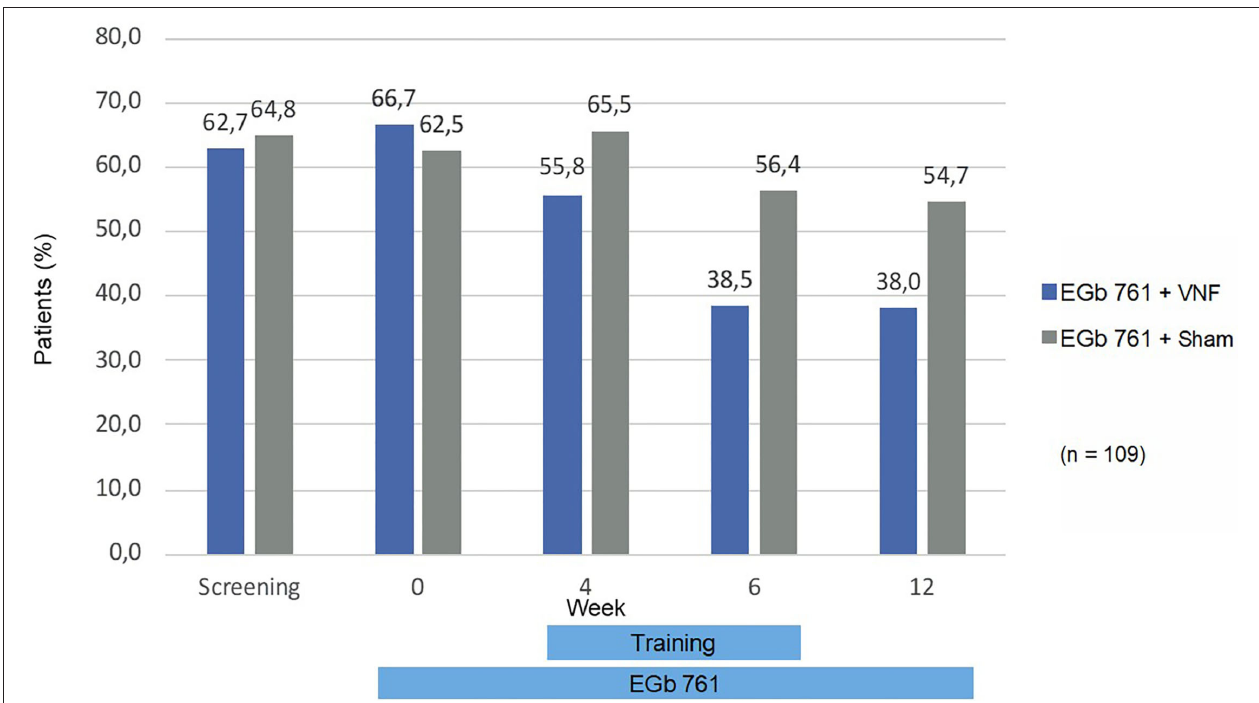
FIGURE 3 | Patients with fall risk > 50% (gSBDT-CS). Percentages are based on number of patients that attended to the respective visit and had a not missing value for the gSBDT composite